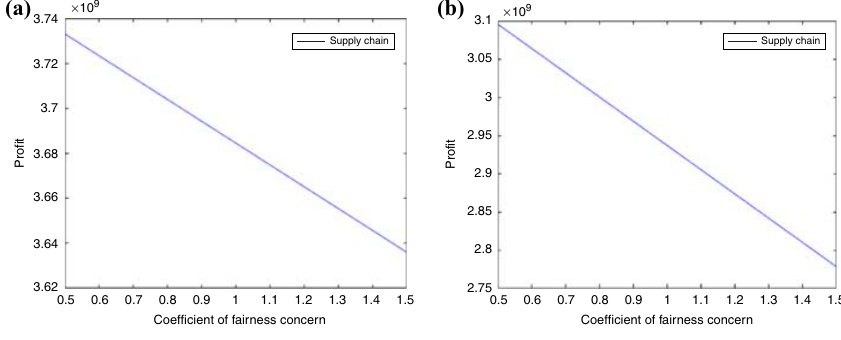
Figure 8. The impact of shortage cost change on the profit of IBWT supply chain without/with fairness concern (FC)